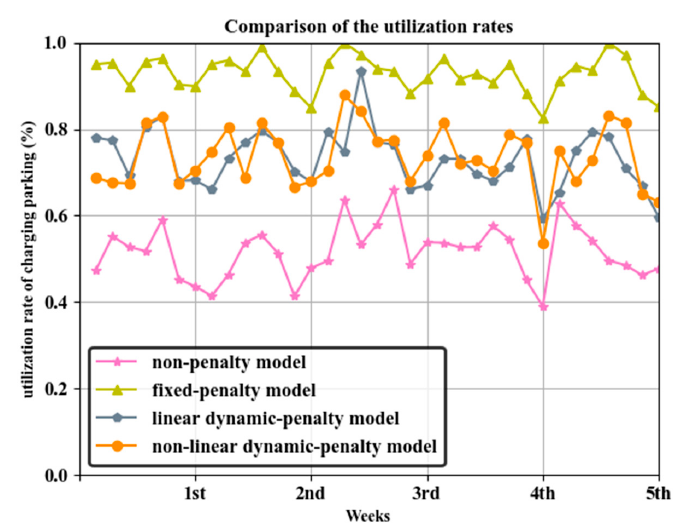
Figure 11. Comparison of the utilization rates.